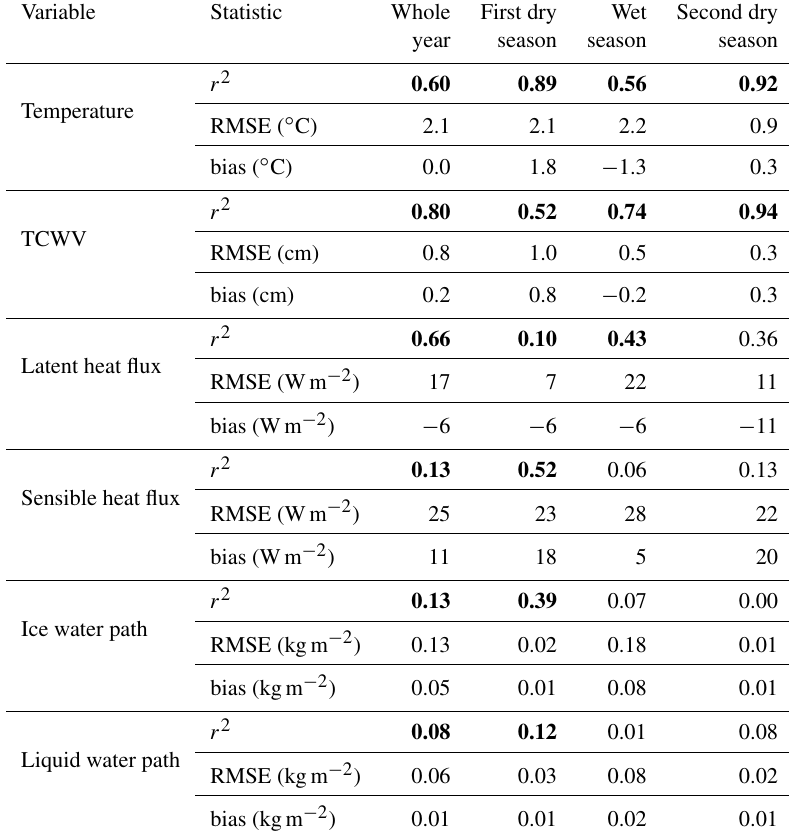
Table 3. Statistics from observation–ERA-I comparison of non-radiative variables for the whole year (days 7–341), first dry season (days 7–125), wet season (days 126–301) and second dry season (days 302–341); Pearson’s r 2 value (bold if significant to p ≤ 0.001), the root mean square error and the bias are all defined in Sect.